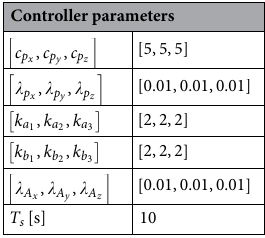
Table 5. Controller parameters.